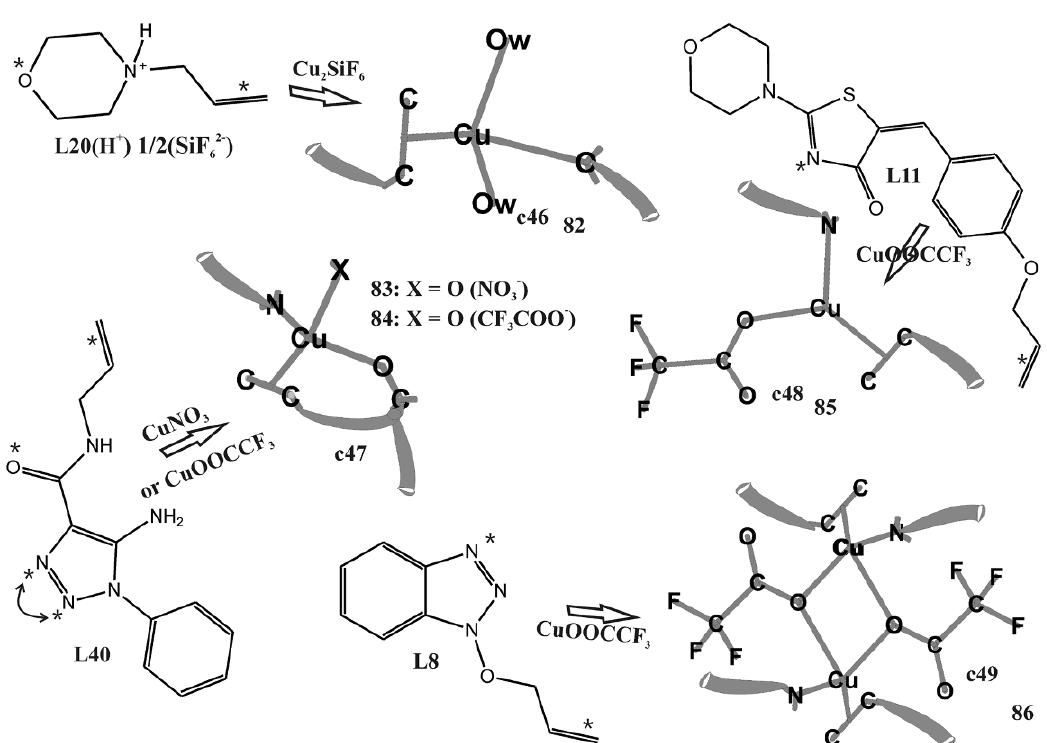
Figure 18. Structural genesis of C46-C49 fragments in 82-86